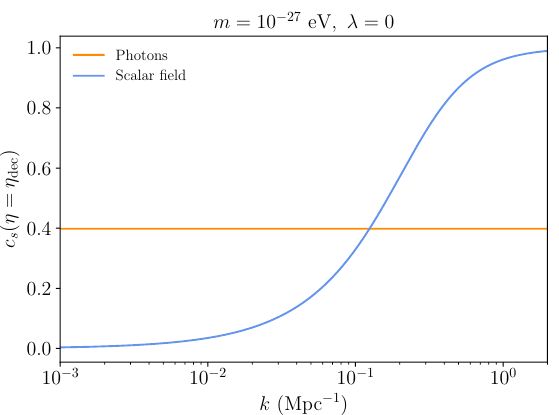
0 : 1 Mpc (cid:0) 1 the ’